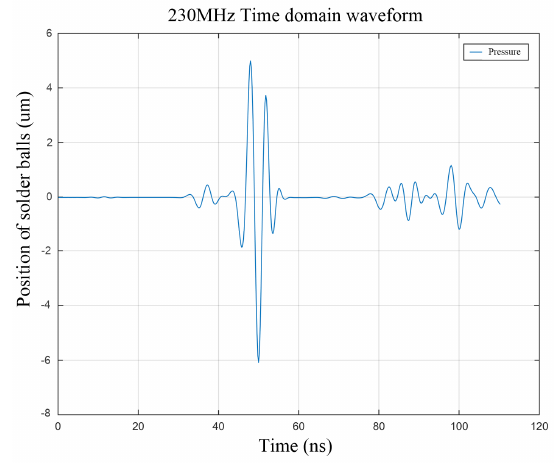
Figure 3. The time-domain signal graph of ultrasound.